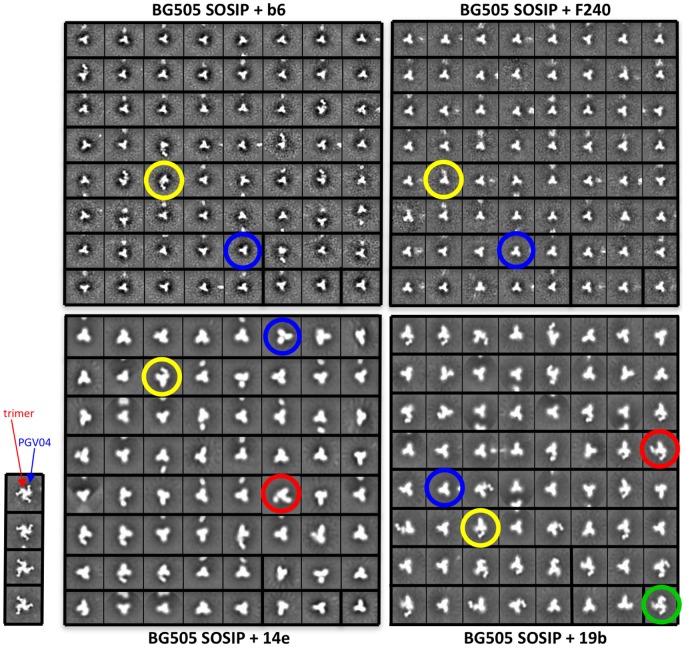
Negative stain EM data of the BG505 SOSIP.664 gp140 trimer in complex with Fabs b6, F240, 14e or 19b.2D class averages of trimers and trimer∶Fab complexes, with 2D class averages of BG505 SOSIP.664 gp140 with PGV04 shown on the lower left panel for comparison. Examples of complexes are circled. Blue circle: no Fab bound to trimer; yellow circle: one Fab bound; red circle: two Fabs bound; green circle: three Fabs bound. For generating b6 complexes, BG505 SOSIP.664 (44 nM; 17,200 ng/ml) was incubated with Fab b6 (480 nM; 24,000 ng/ml) prior to imaging. For generating F240 complexes, BG505 SOSIP.664 (48 nM; 18,720 ng/ml) was incubated with Fab F240 (860 nM; 43,000 ng/ml) prior to imaging. For generating 14e complexes, BG505 SOSIP.664 (14 nM; 5460 ng/ml) was incubated with Fab 14e (240 nM; 12,000 ng/ml). For generating 19b images, BG505 SOSIP.664 (40 nM; 15,600 ng/ml) was incubated with Fab 19b (600 nM; 30,000 ng/ml). The results are summarized in Table 2.